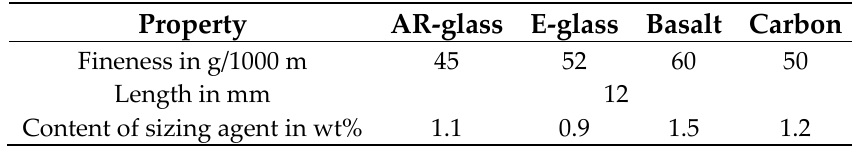
Table 3. Properties of the integral fibers.